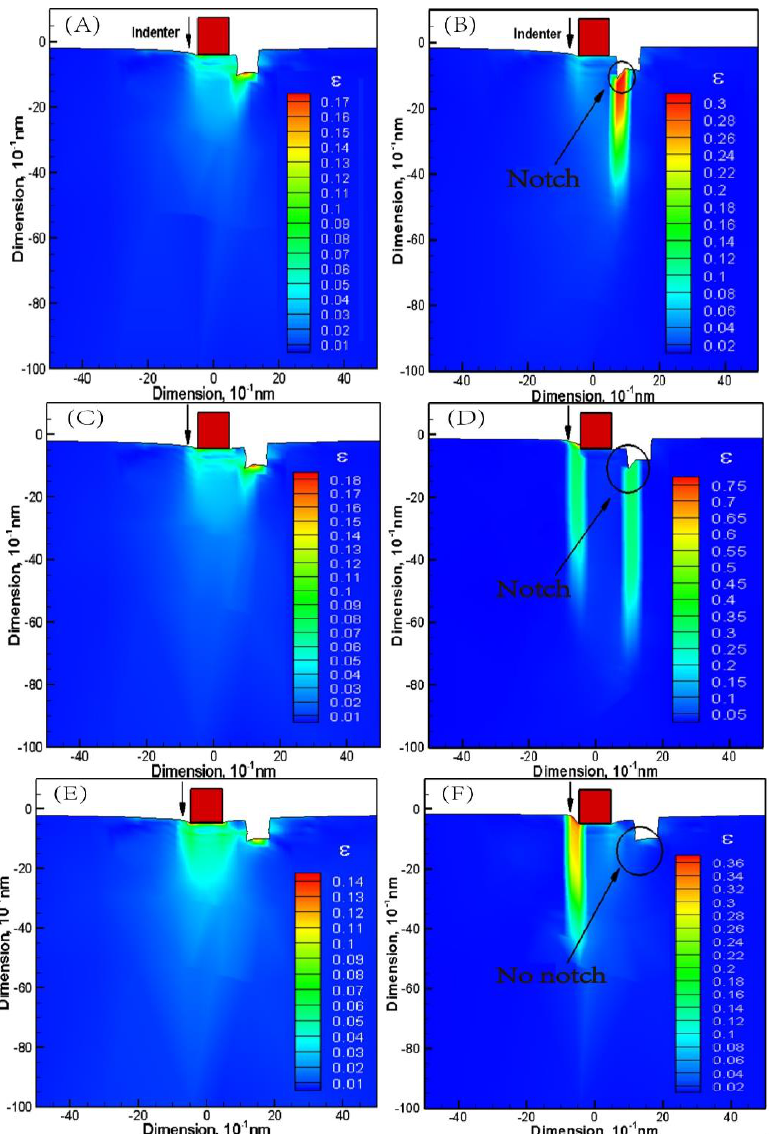
Figure 5. Von Mises strain distribution of notch propagation. ( A ) d = 1d 0 at the load step of the indenter 0.38 nm; ( B ) d = 1d 0 at the load step of the indenter 0.4 nm; ( C ) d = 2d 0 at the load step of the indenter 0.44 nm; ( D ) d = 2d 0 at the load step of the indenter 0.46 nm; ( E ) d = 3d 0 at the load step of the indenter 0.46 nm; ( F ) d = 3d 0 at the load step of the indenter 0.48 nm.